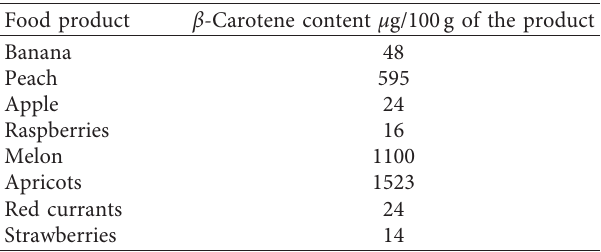
Table 5: β -Carotene content of selected fruits [39]. Food